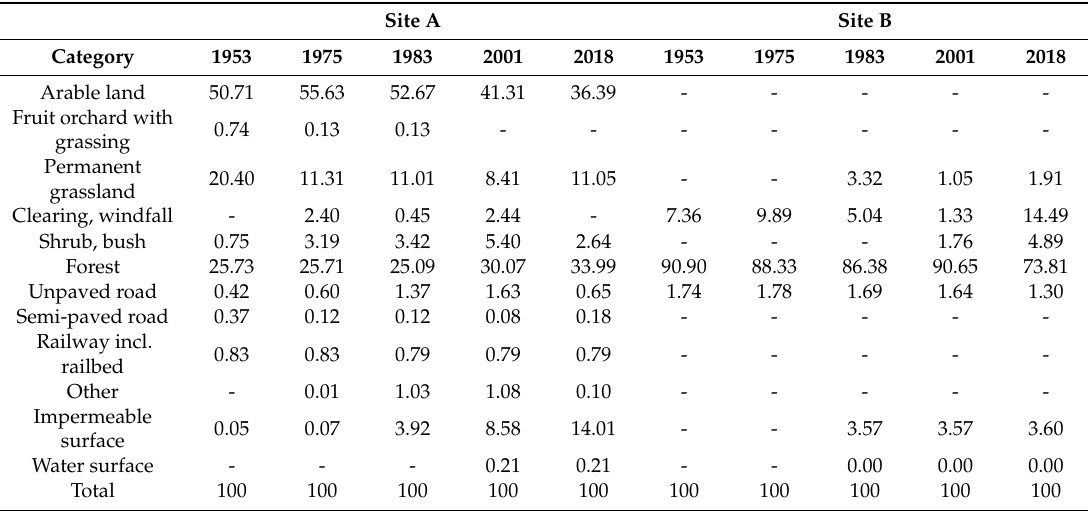
Table 4. Land cover categories and their proportions